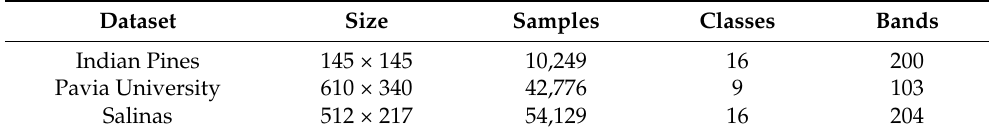
Figure 6. Salinas dataset. ( a ) False color image. ( b ) Ground truth. The details of these three datasets are described in Table 1. Table 1. Description of remote sensing